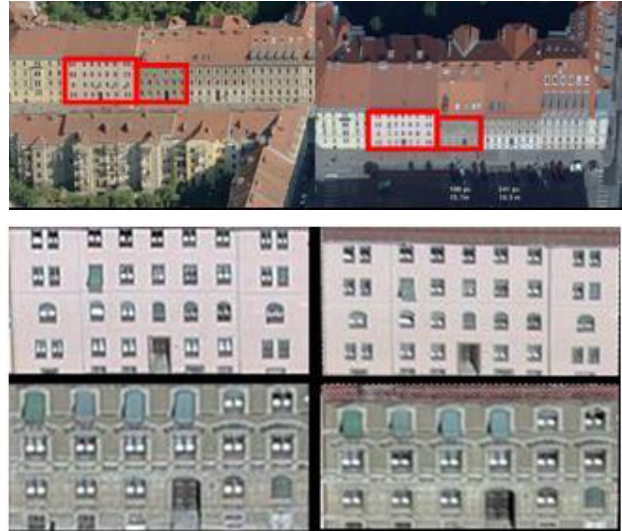
Figure 5. Oblique aerial image at 45° look angle taken from Bing Maps (left) ; Vertical aerial image obtained from UltraCamX at a look angle of 27° (right) . The marked sections in the original image segments (above) have been rectified (below)